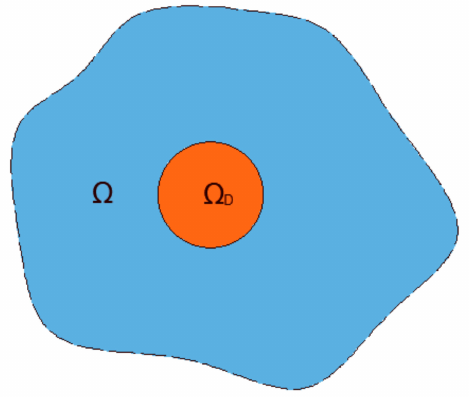
Figure 6. Schematic representation of the